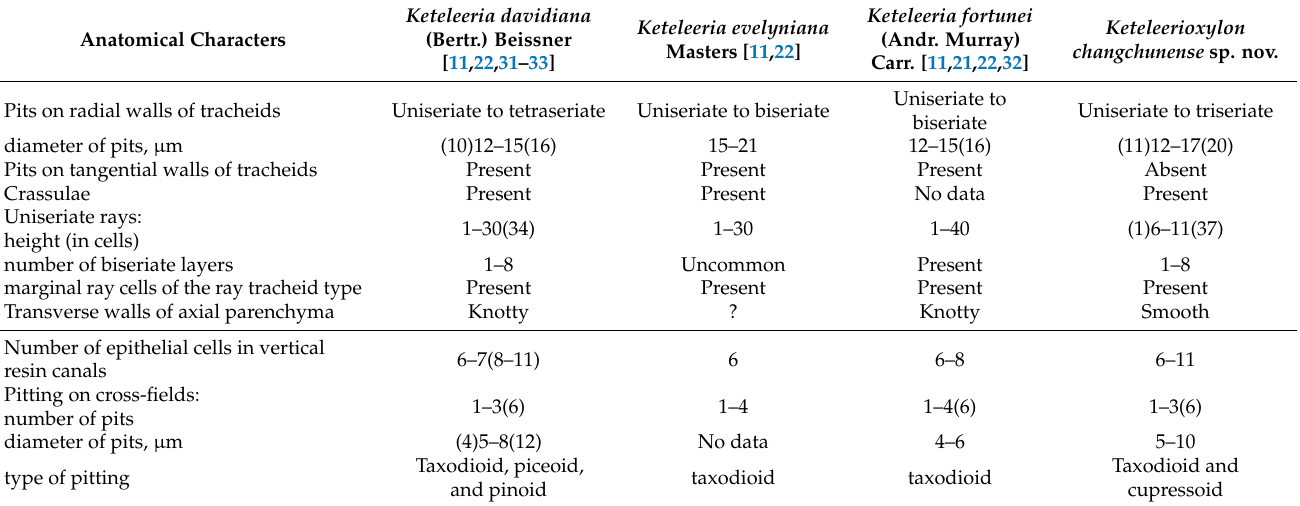
Table 1. Comparison of wood anatomical characteristics of Keteleerioxylon changchunense sp. nov. and woods of extant Keteleeria